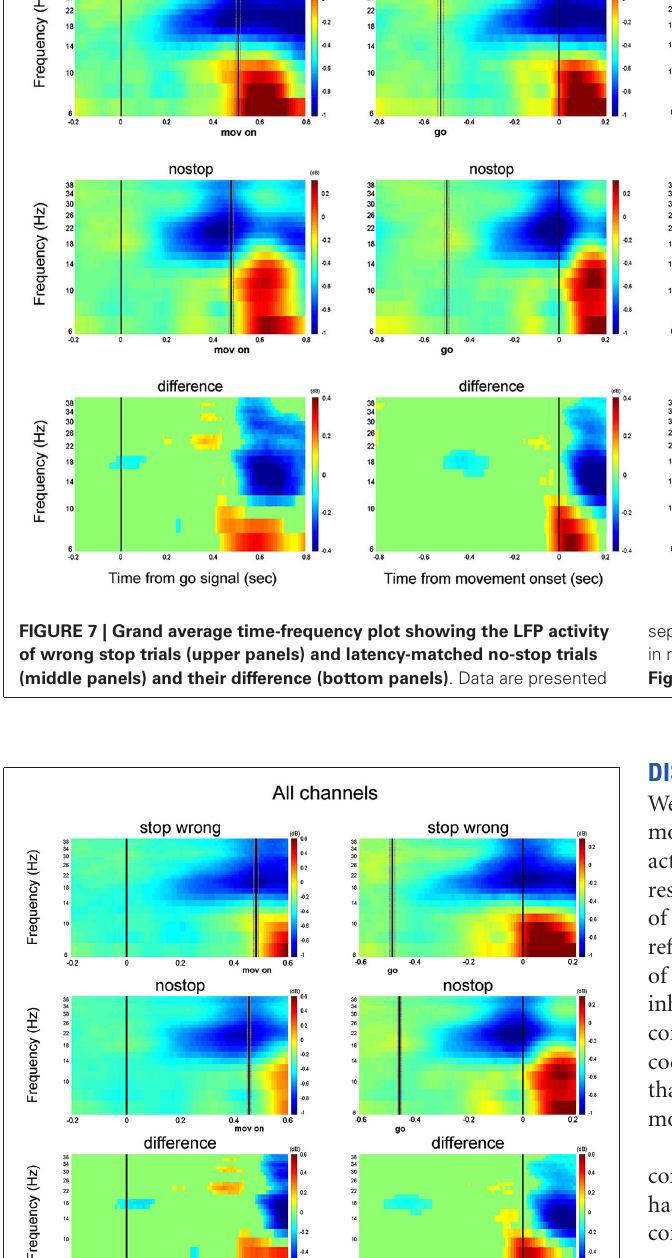
FIGURE 8 | Grand average time-frequency plot across all channels . Other conventions as in Figure 6 .